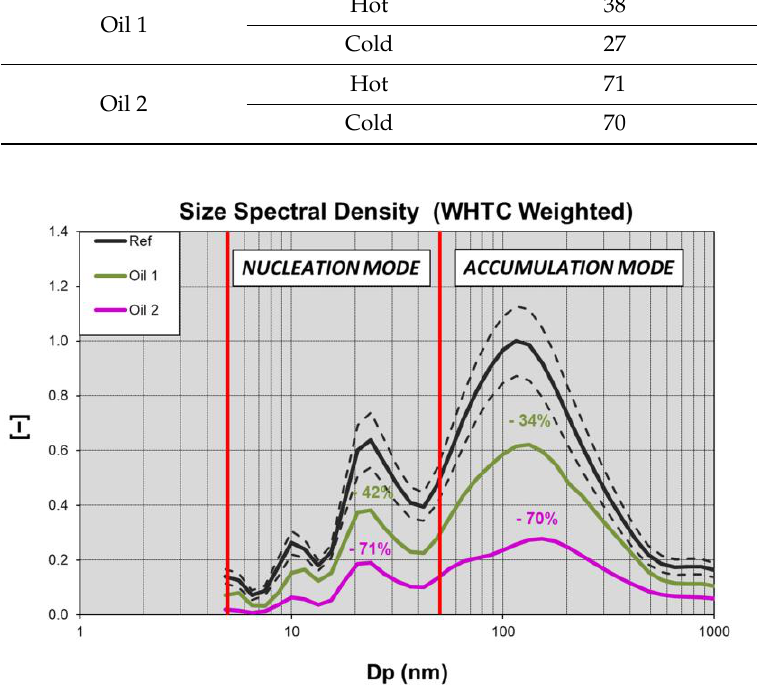
Figure 4. Mean dimensionless PSDFs provided by the tested engine in the WHTC cycle (solid lines). Ref oil standard deviation during the tests (dotted lines).